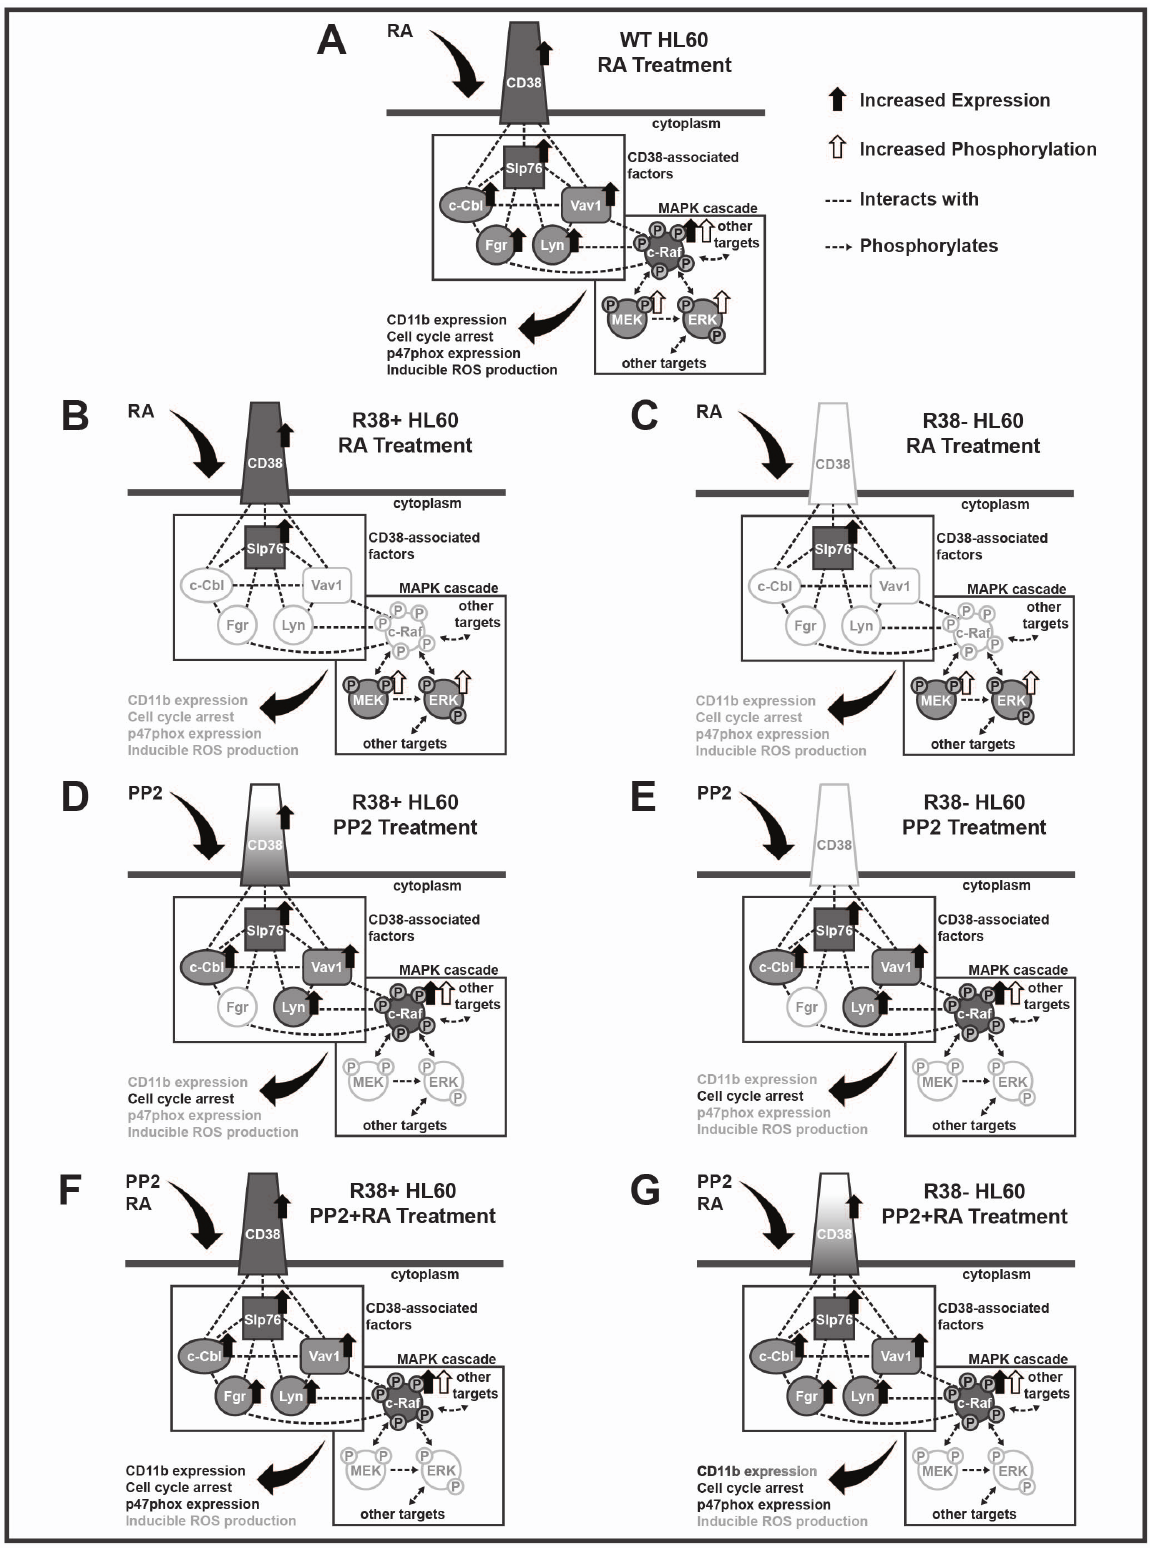
Figure 7. Diagrams of the signaling proteins investigated in this study for each treatment case in R38 + and R38 2 compared to the RA-treated WT HL60 cells. For a given protein, solid black arrows indicate increased expression while white arrows indicate increased phosphorylation. Dashed black lines indicate an interaction that has previously been demonstrated in this lab by immunoprecipitation and/or FRET, with the exception of Fgr:Slp76 and Fgr:c-Raf. These two interactions are implied by the known binding of Slp76 and c-Raf to Src-family kinase members. Dashed black lines with arrowheads indicate phosphorylation (kinase) events known in the literature. Solid-filled factors vs. white-filled